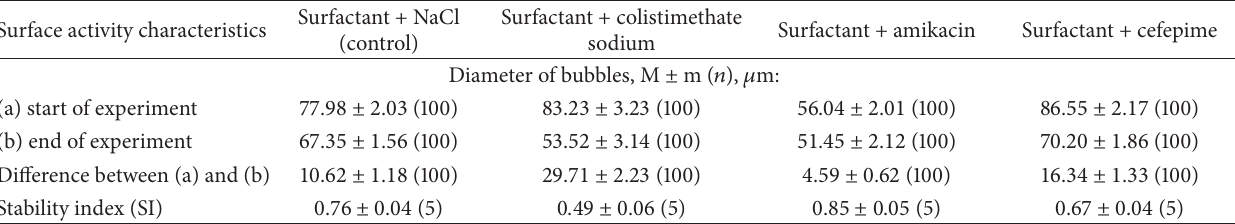
Table 2: Surface activity parameters of experimental mixtures.